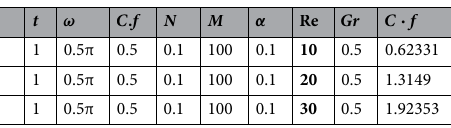
Table 7. Influence of Reynolds number Re on skin friction.